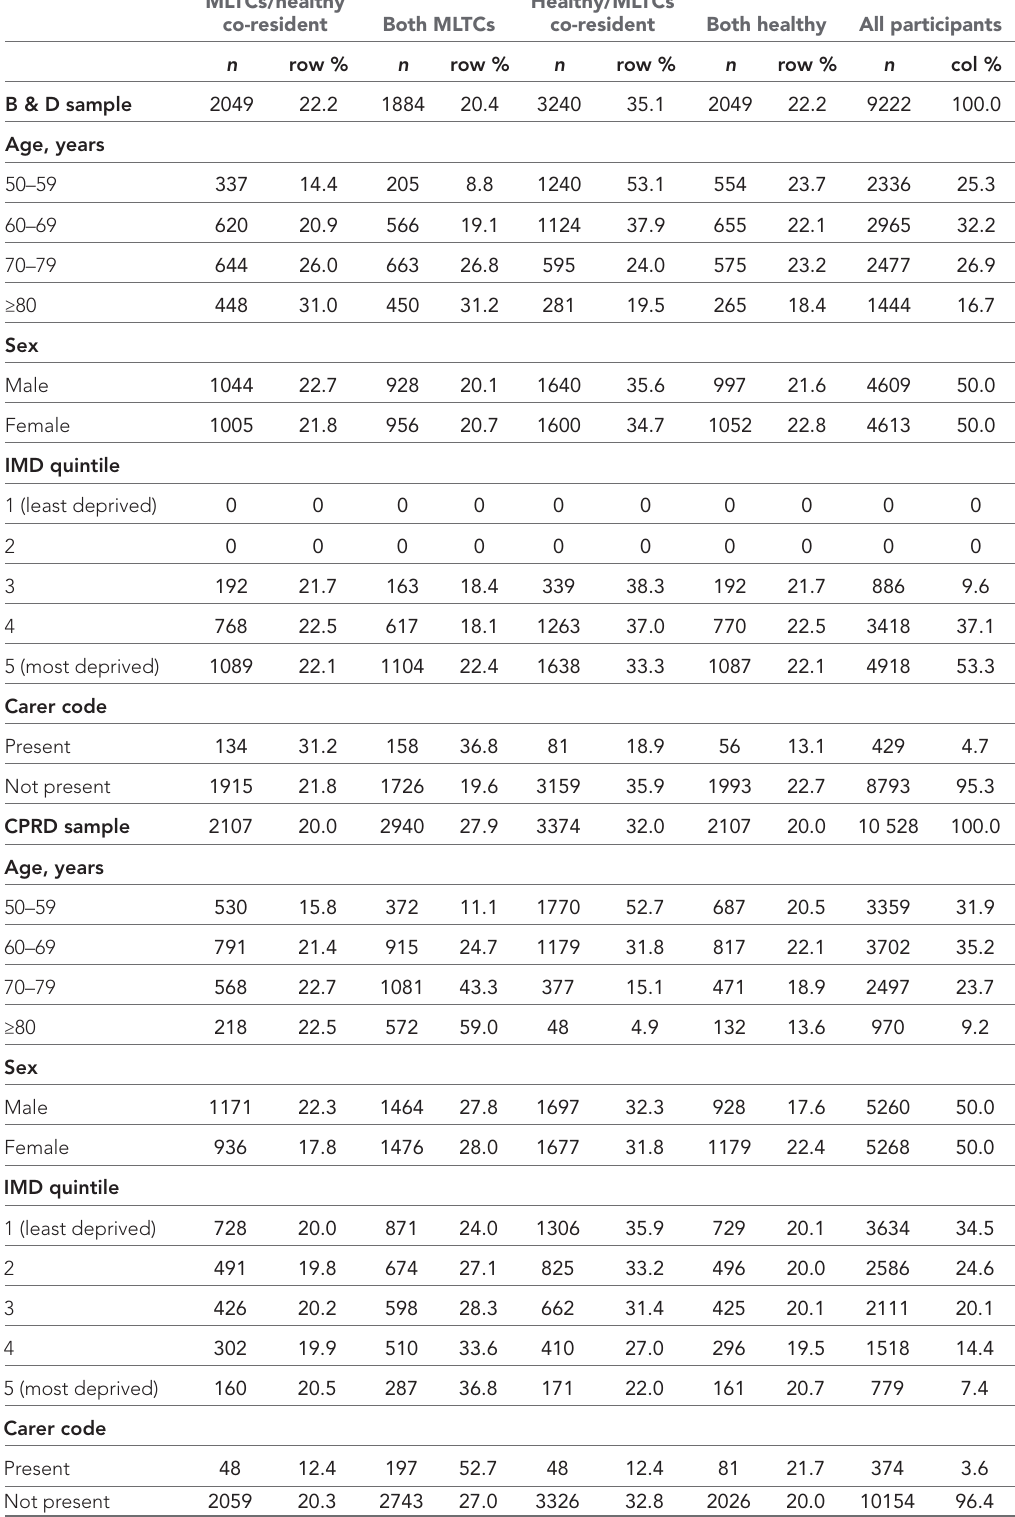
Table 1 Barking and Dagenham and Clinical Practice Research Datalink sample